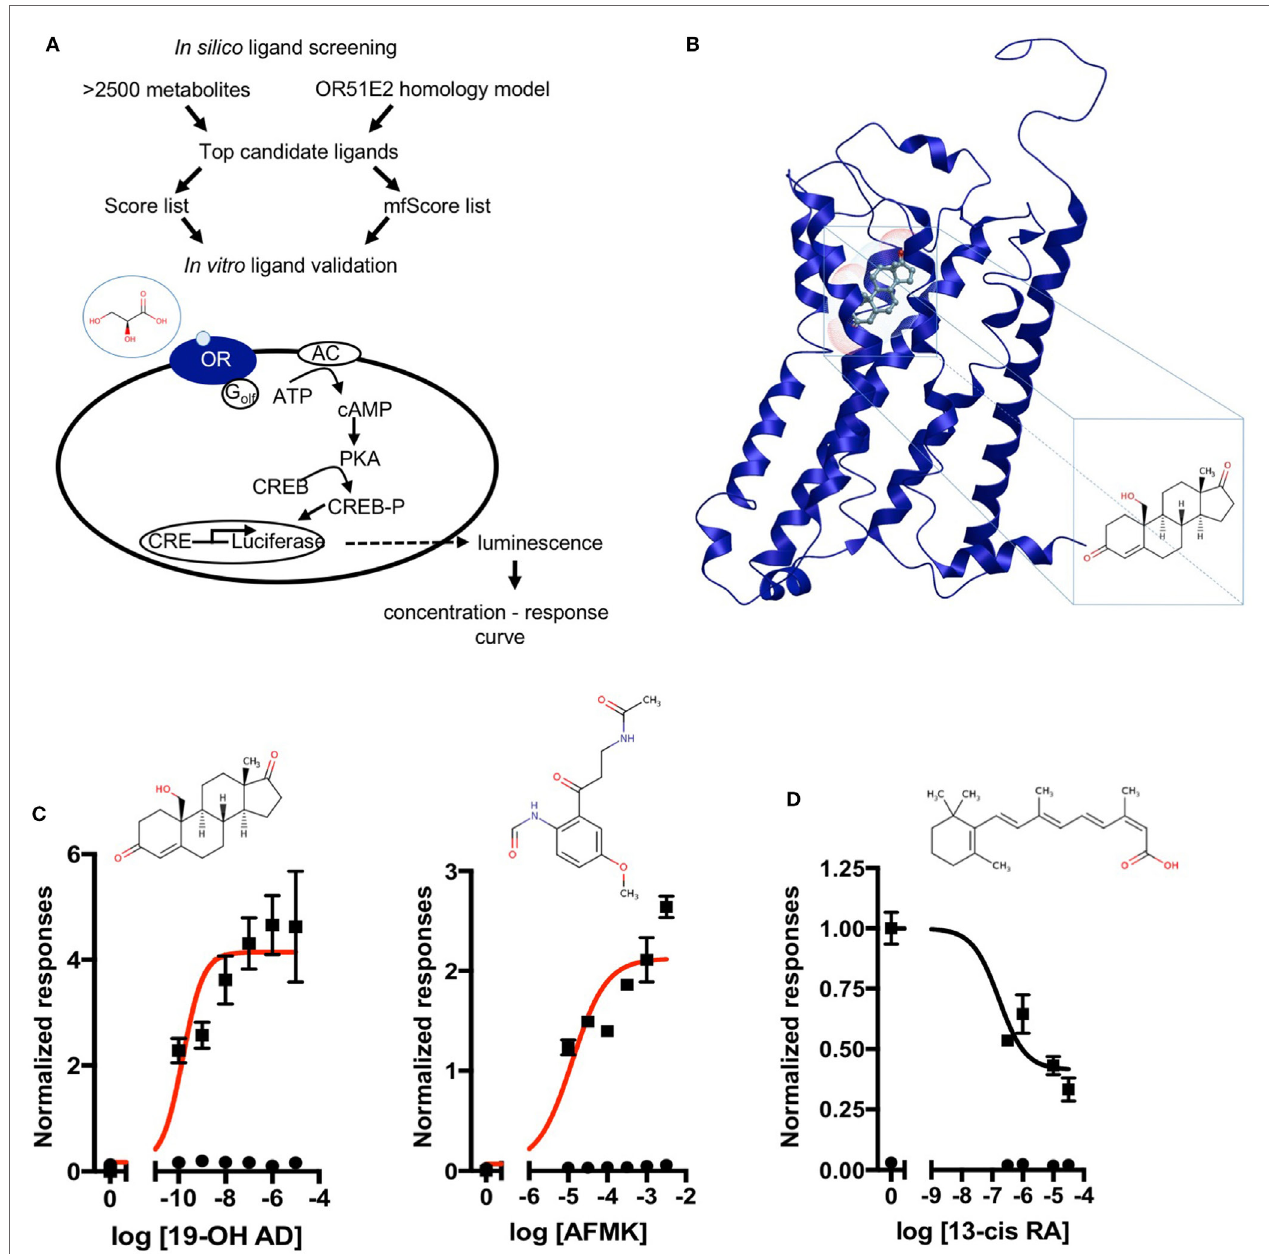
FigUre 1 | Discovery of novel endogenous metabolite-ligands for OR51E2. (a) Study design. (B) Homology model of OR51E2 with 19-hydroxyandrost-4-ene- 3,17-dione (19-OH AD) docked into the receptor pocket. (c) Concentration–response curves for 19-OH AD and acetyl- N -formyl-5-methoxykynurenamine (AFMK) (red) and their structures. Responses are obtained in the M10d medium and normalized to a no-metabolite control (0 = no metabolite stimulation). (D) Concentration–response curve for antagonist 13-cis retinoic acid (13-cis RA) obtained in the CD293 medium. Response is normalized to a no-metabolite control (1 = no metabolite stimulation) (N = 3, mean ±